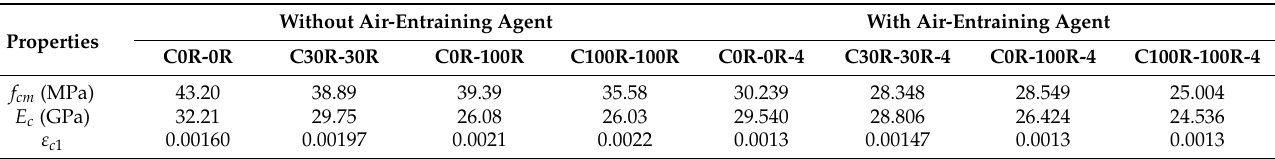
Table 2. Mechanical properties of the tested formulations at 90 days age.